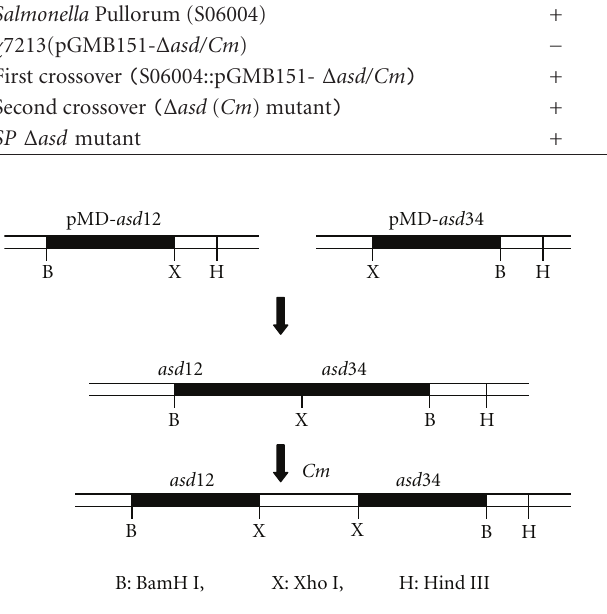
Figure 1: The construction of pMD- asd p1234 ( Cm